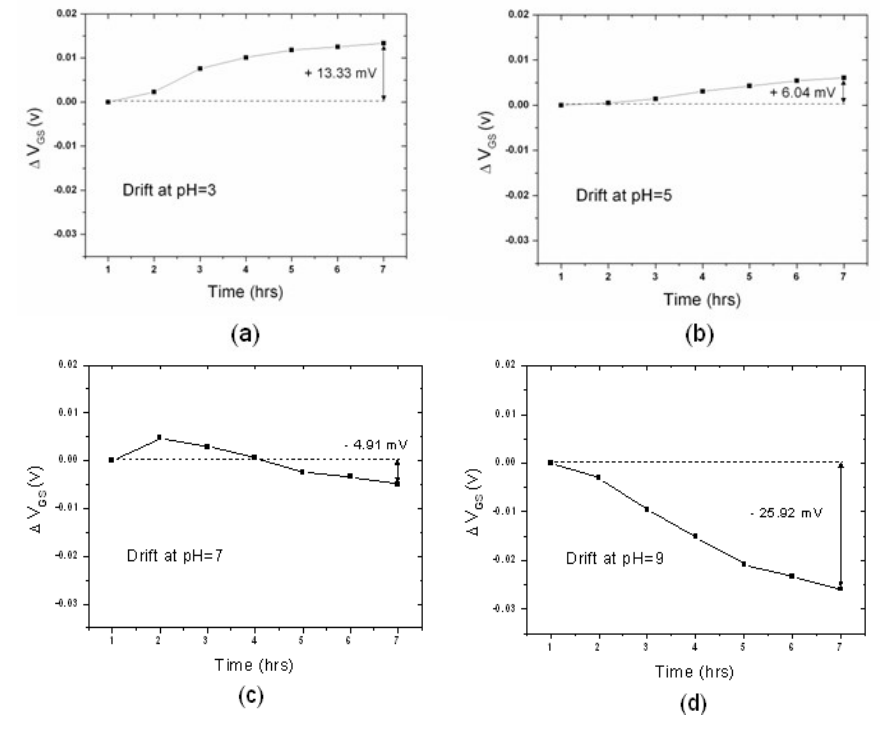
Figure 5. The drift of the p-channel ISFET over the first seven hours at (a) pH3 (b) pH5 (c) pH7 (d) pH9 (e) pH11. The drift over the first seven hours were (a) 13.33mV (b) 6.04mV (c) -4.91mV (d) -25.92mV and (e) -30.82mV,